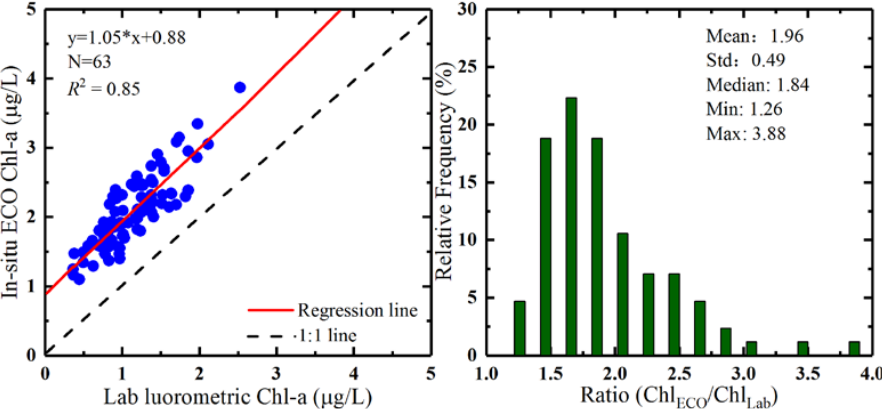
Figure 7. Regression analysis and comparison of lab fluorometric and ECO Chl-a.